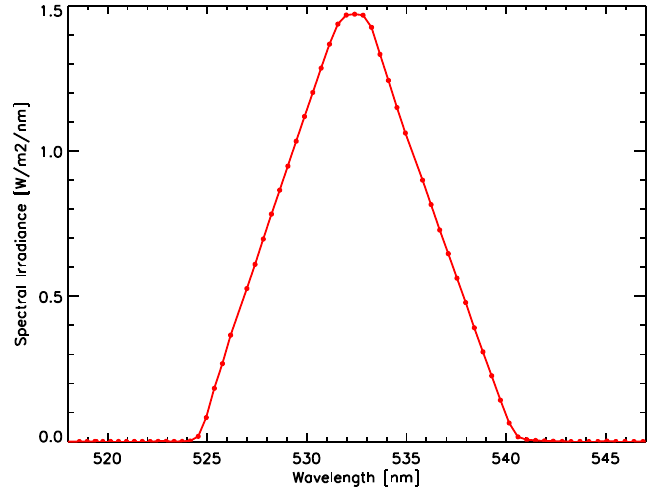
Figure 13. The result of the conversion of the raw data number (DN) vs. sub-pixel data shown in Figure 12 using the SIM measurement equation (Equation (4)). The conversion results in the spectral irradiance (Wm − 2 nm − 1 ) as a function of wavelength, the spectral response function, for SIM at 532 nm central wavelength. Integrating this spectrum with wavelength allows for a direct irradiance comparison (Wm − 2 ) with the cryogenic radiometer. For this measurement, SIM yields an irradiance of 15.969 ± 0.024 Wm − 2 (k = 1) (~700 ppm higher than the cryogenic radiometer value of 15.958 Wm − 2 , validating the measurement equation at the 0.1% level for 532 nm.).